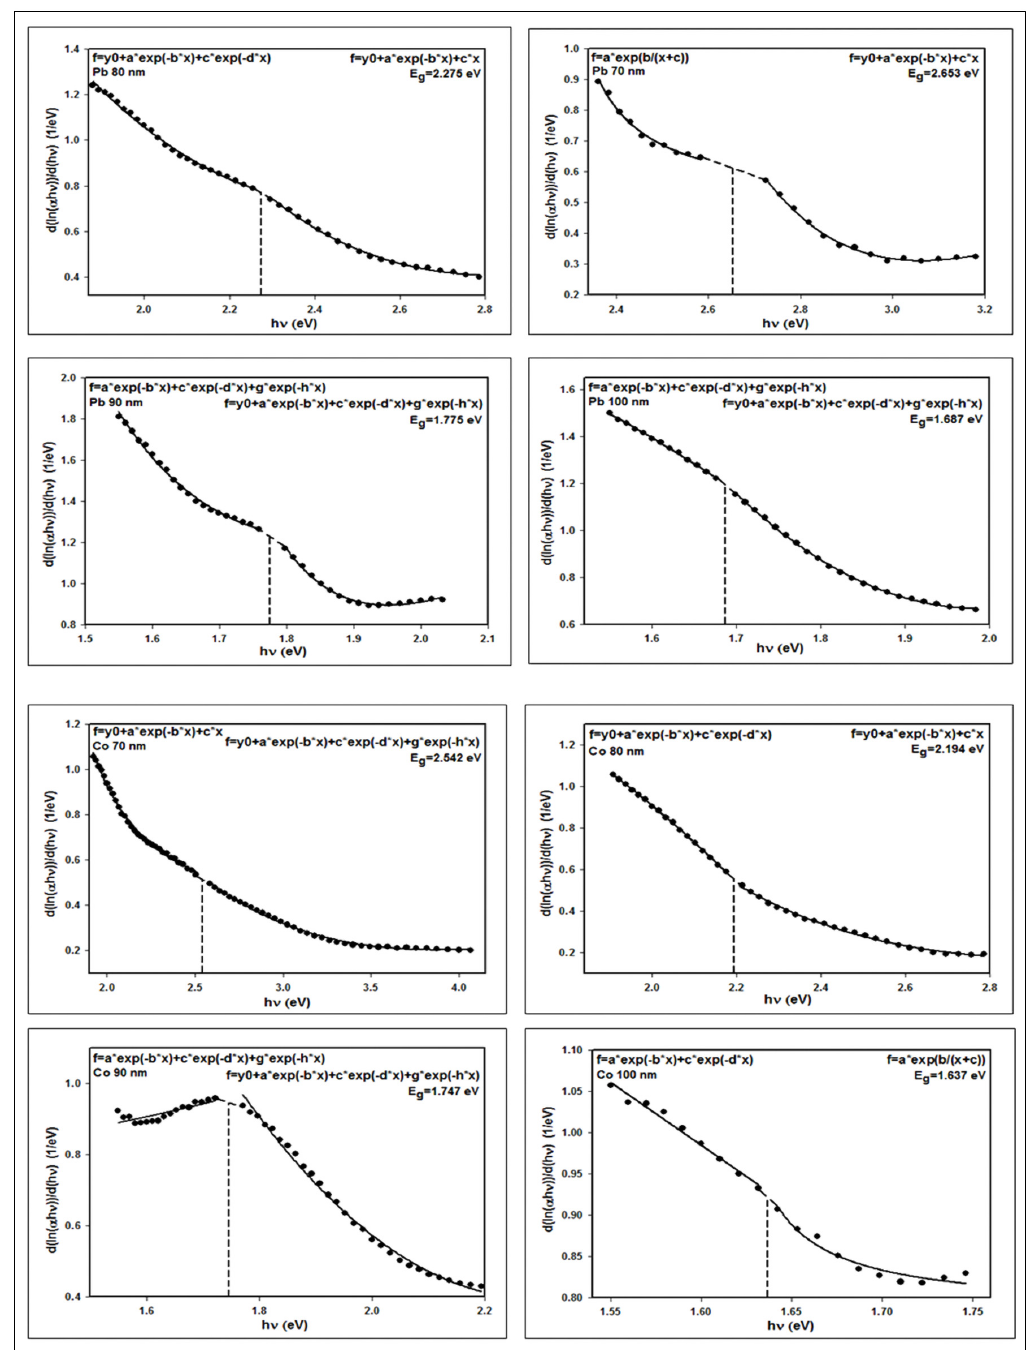
Figure 7. ( A ) COMSOL-simulated plots of d ( ln ( α h ν )) / d ( h ν ) versus h ν for the U and Th nanoparticles, displaying a discontinuity on the computed band gap energy value. ( B ) COMSOL-simulated plots of d ( ln ( α h ν )) / d ( h ν ) versus h ν for the Pb and Co nanoparticles, displaying a discontinuity on the computed band gap energy value. The extracted band gap values of the uranium, lead, cobalt, and thorium nanoparticles employing the aforementioned method are presented in Table 2.